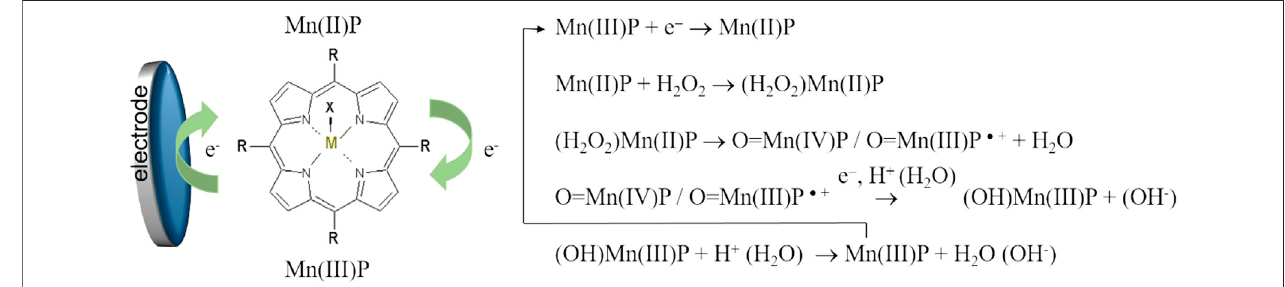
Frontiers in Chemistry |